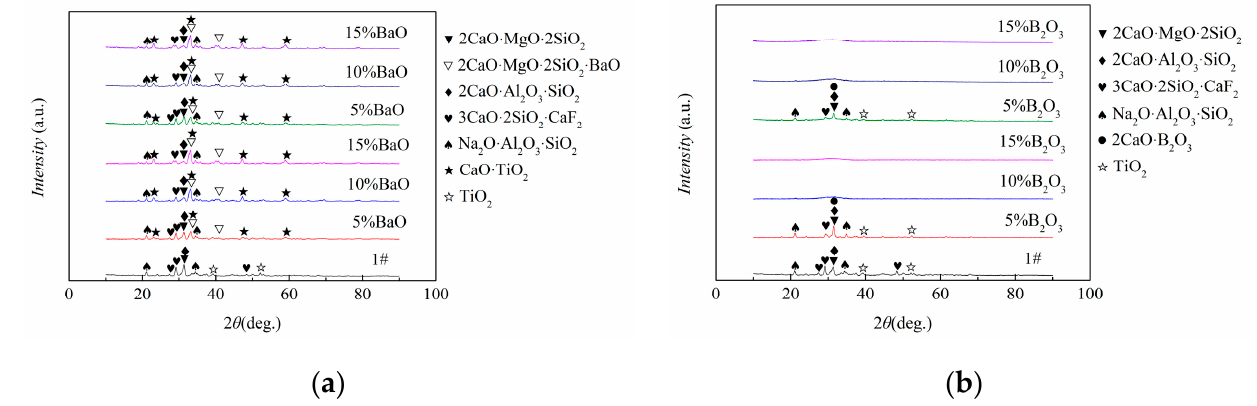
Figure 5. XRD pattern of mold fluxes after absorbing Ti inclusions: ( a ) BaO; ( b ) B 2 O 3 .